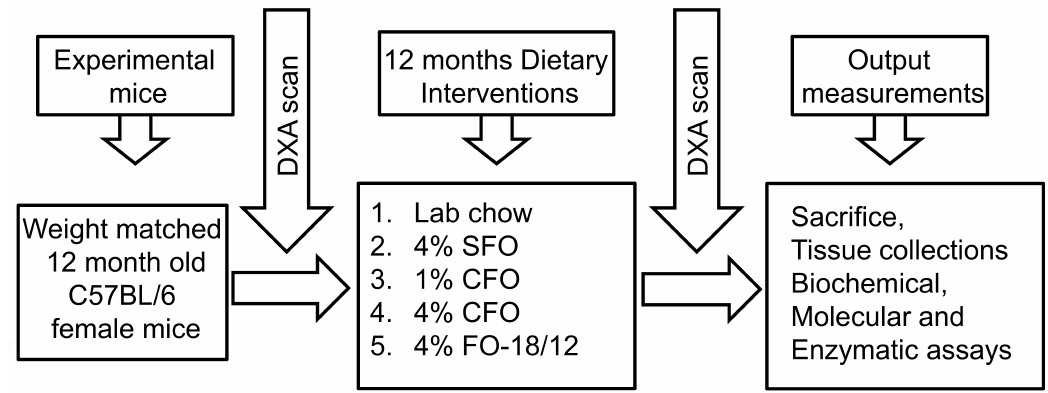
Figure 1. Schematic presentation of the experimental design. Twelve months old C57BL / 6 mice were fed AIN93M diets containing 4% sa ffl ower oil (SFO), 1%, and 4% concentrated fish oil (CFO) and 4%